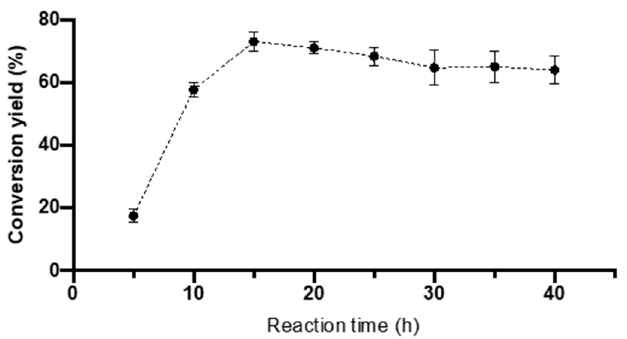
Figure 7. Ester productivity at different reaction times between 5 and 40 h. All measurements were performed in triplicate.